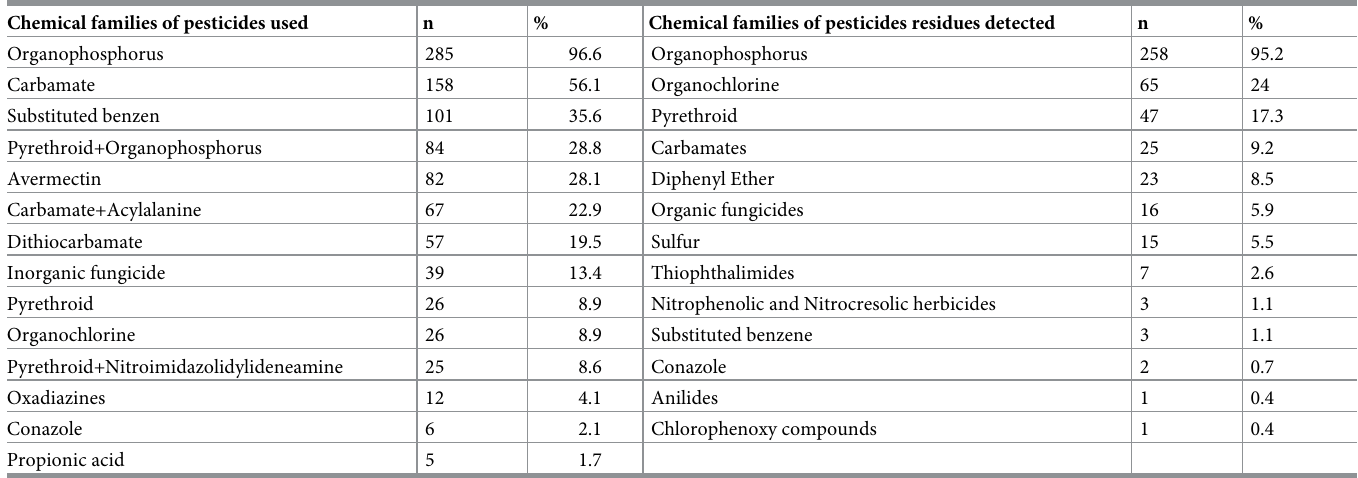
Table 2. Classes of pesticides used and residues detected from fresh